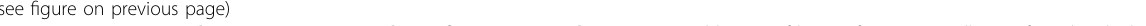
Fig. 6 AXIN1 was critical to YTHDF2-promoted Wnt/ β -catenin signaling. a Immunoblotting of lysates from A549 cells transfected with shNC, shYTHDF2#2, shYTHDF2#2, and/or shAXIN1-1 or shAXIN1-2. Expression levels of YTHDF2 and AXIN1 were measured. β -actin was used as a loading control. b Live cell count, c colony formation, d migration, and e immunoblotting of AXIN1/Wnt/ β -catenin downstream targets in cells described in a . f Immunoblotting of lysates from A549 cells transfected with shCtrl, YTHDF2, AXIN1, YTHDF2, and/AXIN1 vector. Expression levels of YTHDF2 and AXIN1 were measured. β -actin was used as a loading control. g Live cell count, h colony formation, i migration, and j immunoblotting of AXIN1/Wnt/ β -catenin downstream targets in cells described in f .